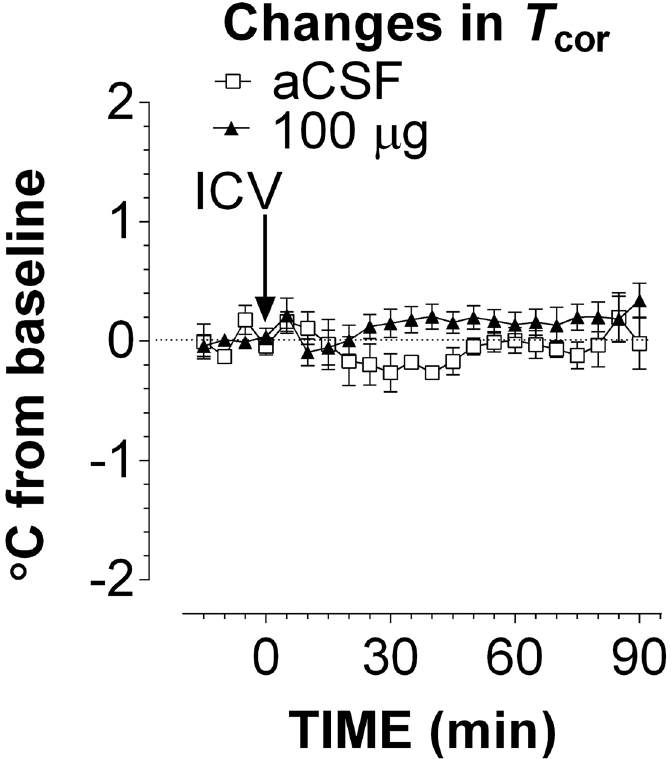
Fig 5. Relationship between intracranial injection of MDMA and occurrence of serotonin syndrome in male Sprague-Dawley rats. The route of intracranial administration was ICV. Serotonin syndrome was determined by measuring changes in T cor . Arrows indicate the time of ICV administration of aCSF ( □ ) or 100 μ g ( ▲ ). Data are expressed as mean ± s.e.m (n = 5 rats/group). ICV administration of 100 μ g MDMA had no effect on T cor